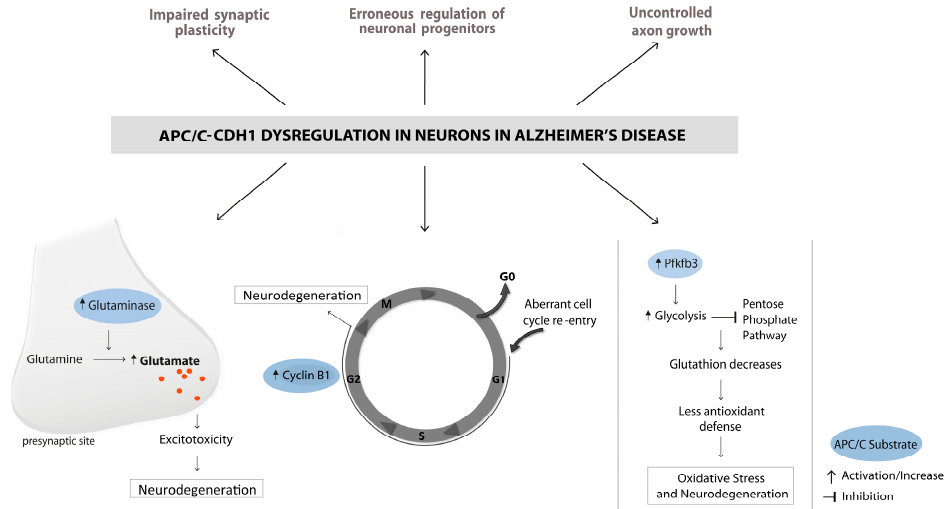
Figure 4. Dysregulation of APC/C-Cdh1 in Alzheimer’s Disease (AD) may affect several different functions in neurons. Pathways involving APC/C substrates that cause excitotoxicity, cell cycle re-